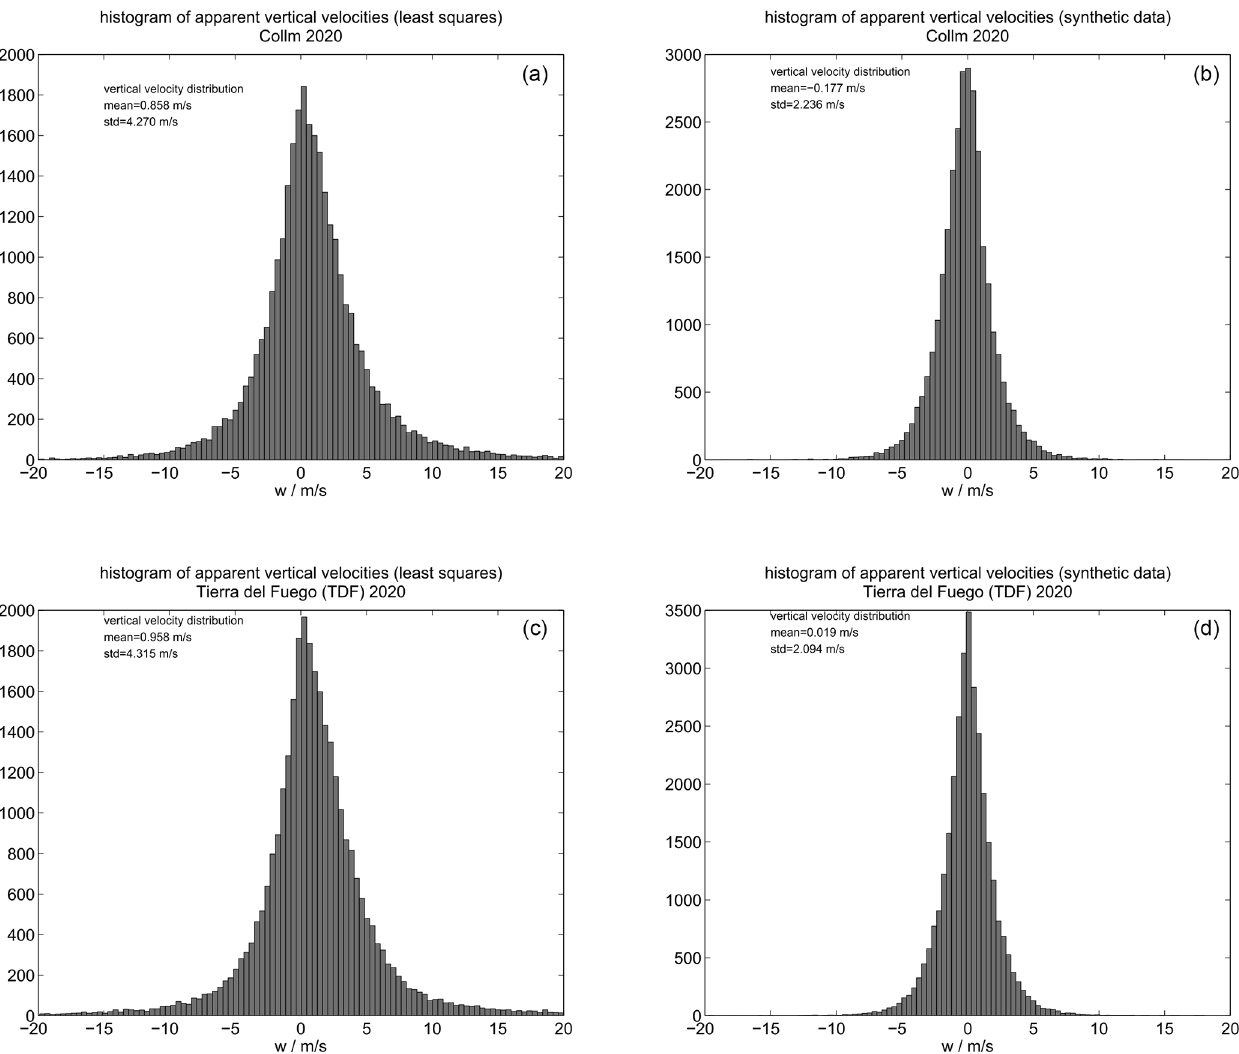
Figure 1. Histograms of the residual bias vertical velocities derived from the COL and TDF meteor radars using observations from January to March 2020. The left histograms (a,c) show the results of the hourly residual bias vertical velocities applying a least-squares fit. The right panels (b,d) show the resulting vertical velocities applying the same algorithm using the COL and TDF detections (volume sampling), but with synthetic data based on mean winds, planetary waves, and tides as well as a zero vertical